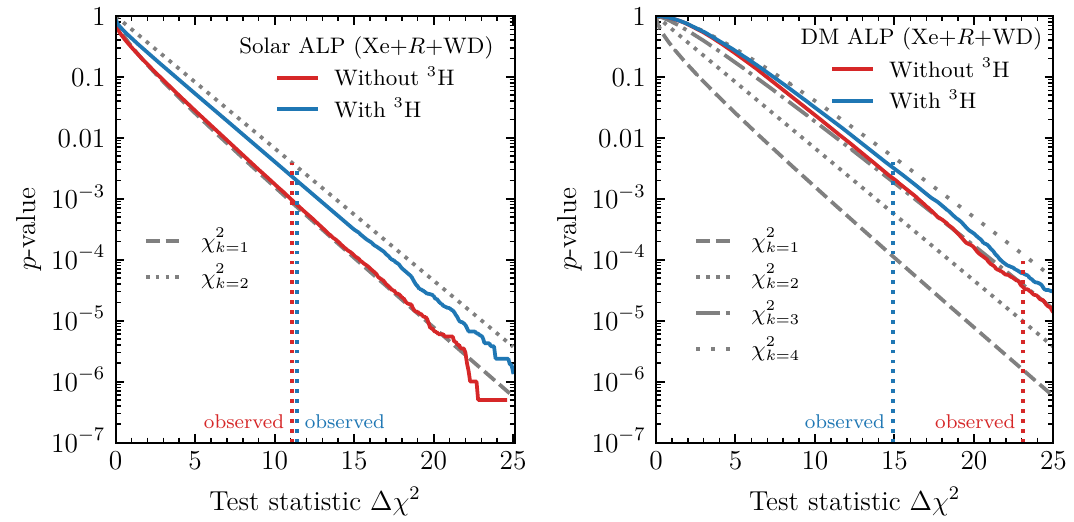
Figure 8. Relationship between p -value and ∆ χ 2 found from Monte Carlo simulations for the solar ALP ( left ) and the DM ALP ( right ) cases, using Xe + R + WD data and with (blue) or without (red) a 3 H component. Vertical dotted lines in the corresponding colours denote the observed value of the test statistic. We also show analytically calculated p -value for various χ 2 k degrees of freedom (grey